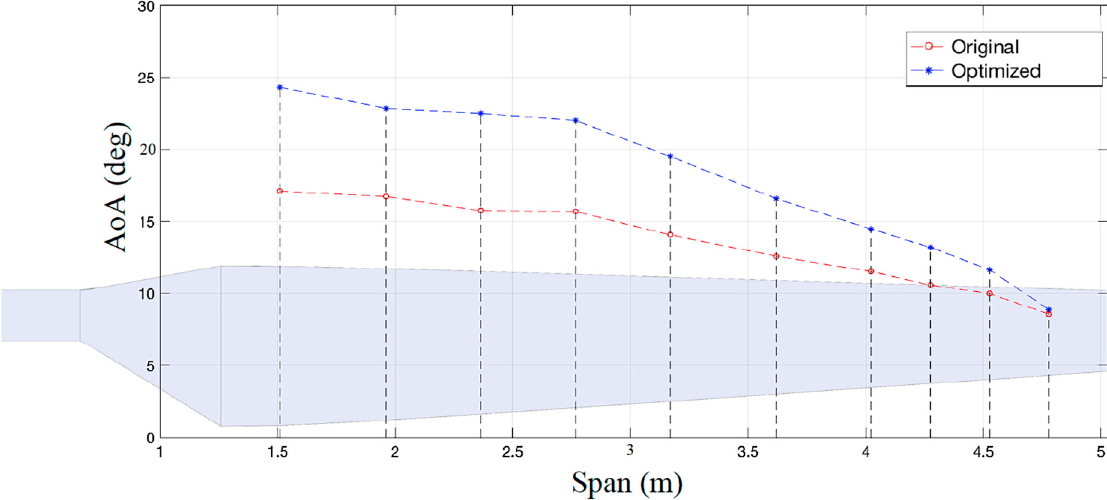
Figure 18. Angle of attack distribution for the optimized blade at 10 m/s.